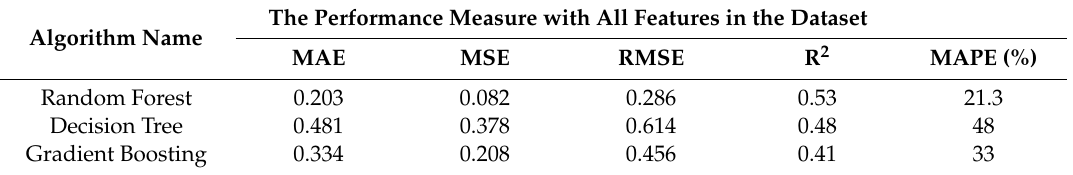
Table 4. Performance metric evaluation of machine learning models with algorithm inbuilt feature importance method.